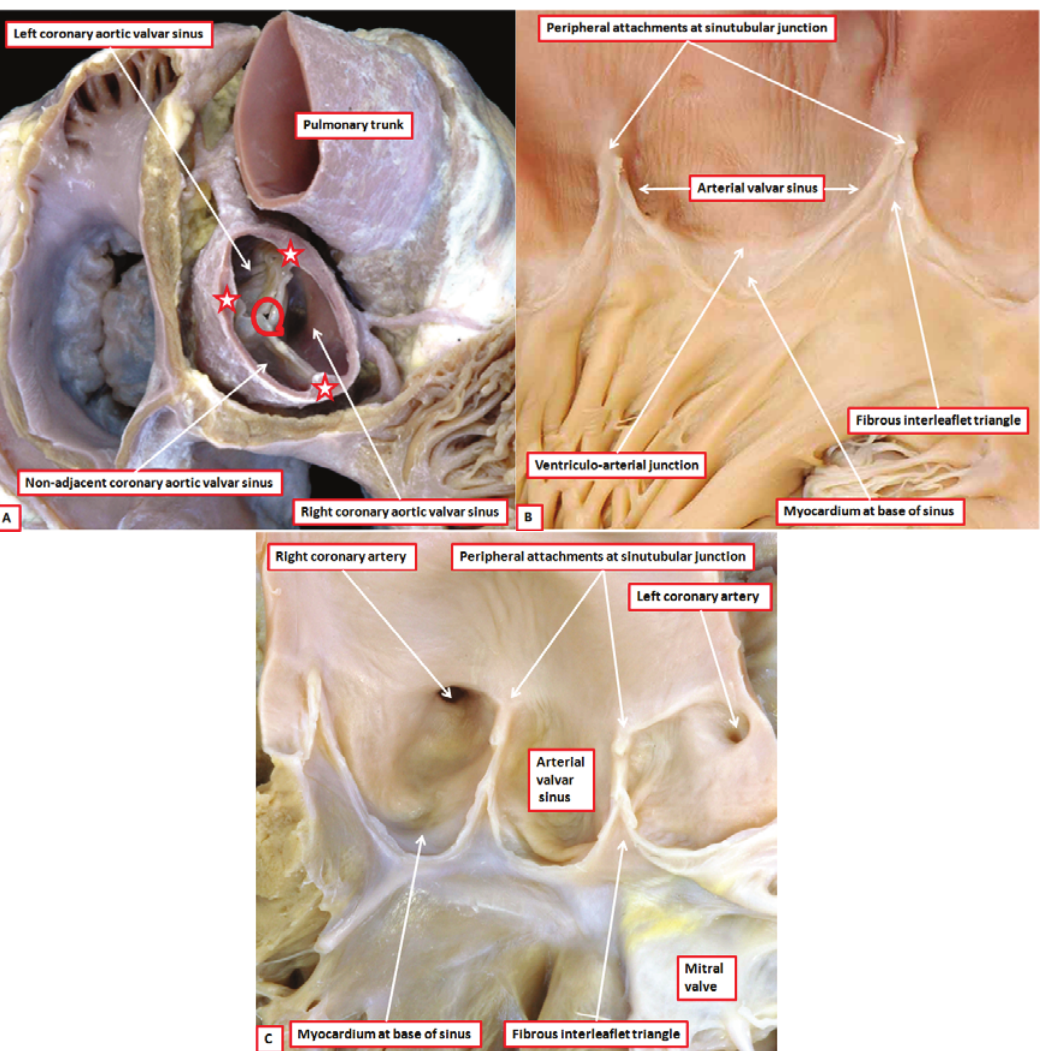
Figure 2. Dissections showing the structure of the arterial valves in the human